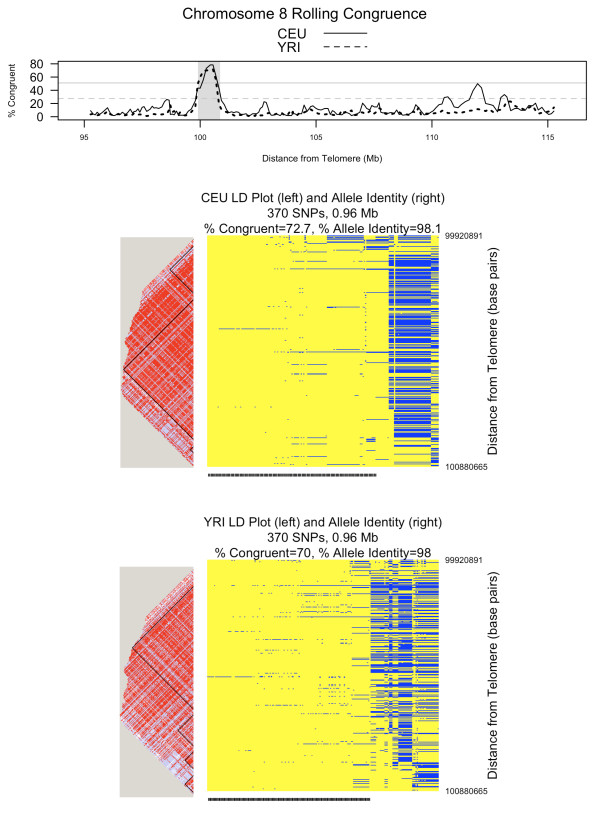
Comparing unrelated HapMap populations: chromosome 8. This figure shows rolling congruence over a section of chromosome 8. Detailed linkage disequilibrium (LD) plots with haplotype blocks and allele identity plots correspond to the shaded peak. The two horizontal reference lines on the rolling congruence plot correspond to the 99th percentile of congruence observations across the genome. That value is 51.1% for CEU (solid line) and 27.5% for YRI (dotted line). On the LD plots, shades of red indicate increasing D'. For the allele identity plots, each column is one chromosome (as represented by 370 SNPs and 0.96 Mb) and each row is a SNP. Yellow represents alleles that match the consensus sequence whereas blue represents alleles that do not match the consensus. Congruent chromosomes are indicated by the tick mark at the bottom of the allele identity plot. This peak on chromosome 8 is characterized by both high CEU and high YRI congruence